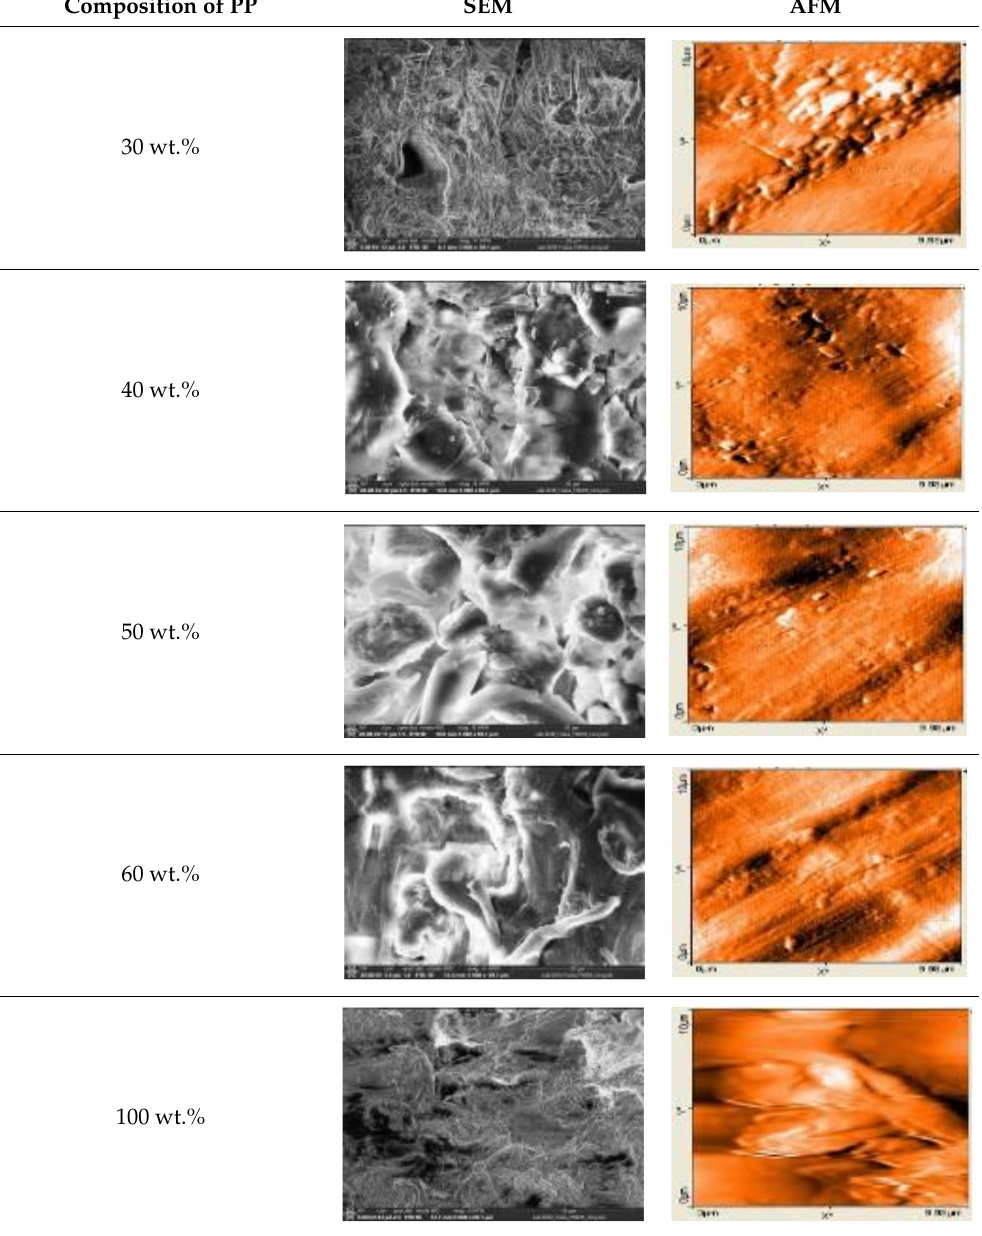
Table 4. SEM and AFM images for the various compositions of